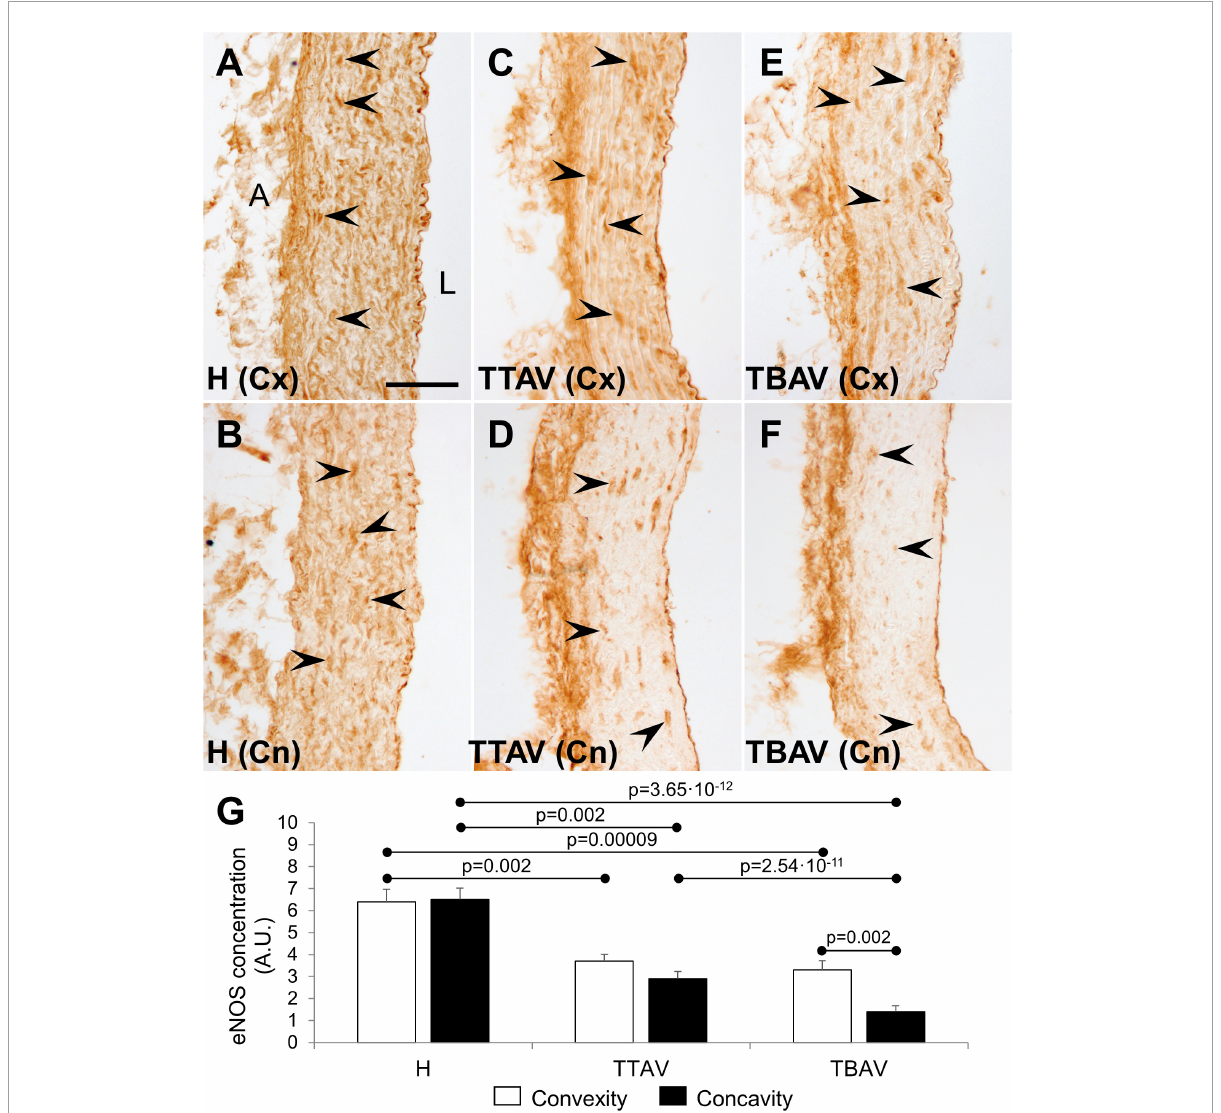
FIGURE4 Endothelial nitric oxide synthase immunoperoxidase in the convexity (Cx; A,C,E ) and concavity (Cn; B,D,F ) of the ascending aorta of hamsters from the control (A,B) and the affected (C–F) strains. All specimens showed strong immunoreactivity in the endothelium, close to the lumen (L), and the adventitia (A). Medial eNOS + smooth muscle cells (arrowheads) were abundant and homogeneously distributed in animals from the control strain (A,B) , but they were scarce and scattered in animals of the T strain (C–F) , particularly at the aortic concavity (D,F) . No signal was detected in the negative control (not shown). Scale bar: 50 µ m. (G) Quantification of the aortic media area occupied by eNOS + cells. Expression was reduced almost by halve in both the convexity and the concavity of animals of the T strain. Convexity and concavity showed similar eNOS expression except in animals with BAV, in which the reduction in the concavity was even more pronounced. H, control strain; TBAV, bicuspid aortic valve from the affected strain; TTAV, tricuspid aortic valve from the affected strain. Only significant p -values are